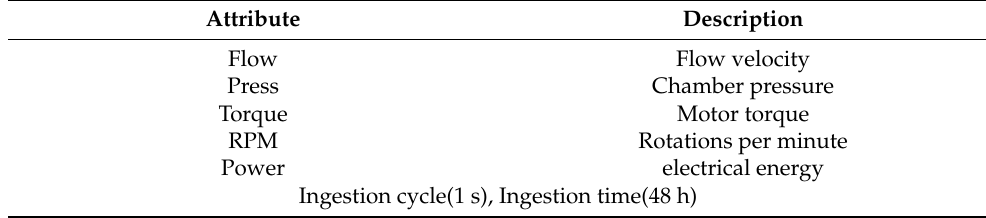
Figure 4. Raw data obtained in the WHM: ( a ) Long period; ( b ) Short period. Table 4. OWC sensor attribute table.